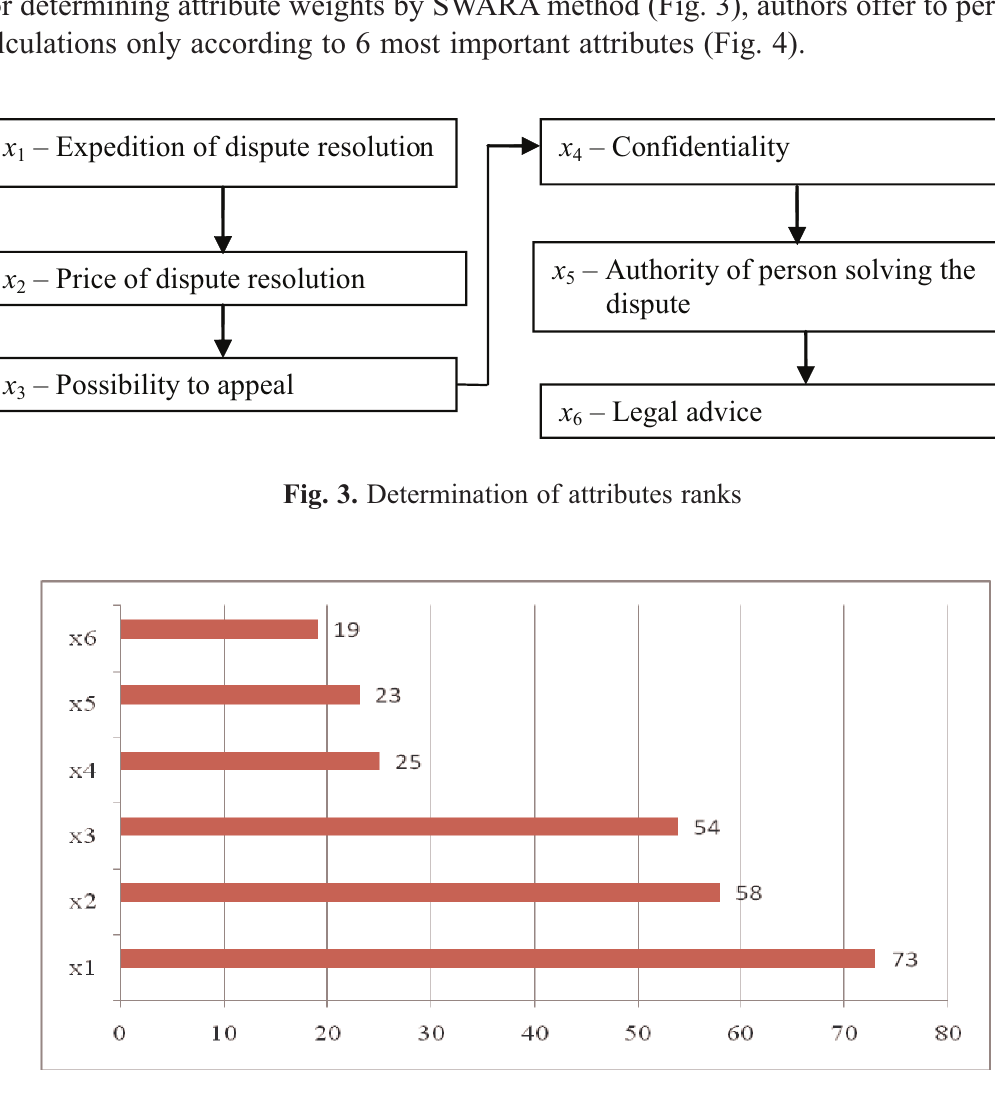
Fig. 4. Most important attributes in selection of dispute resolution